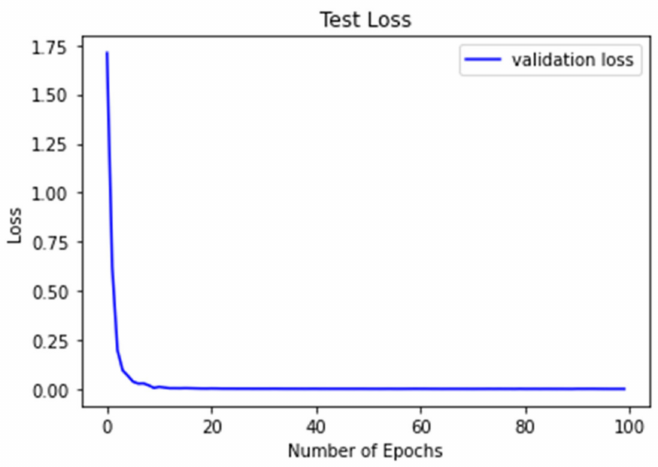
Figure 15. Converge curve of the trained